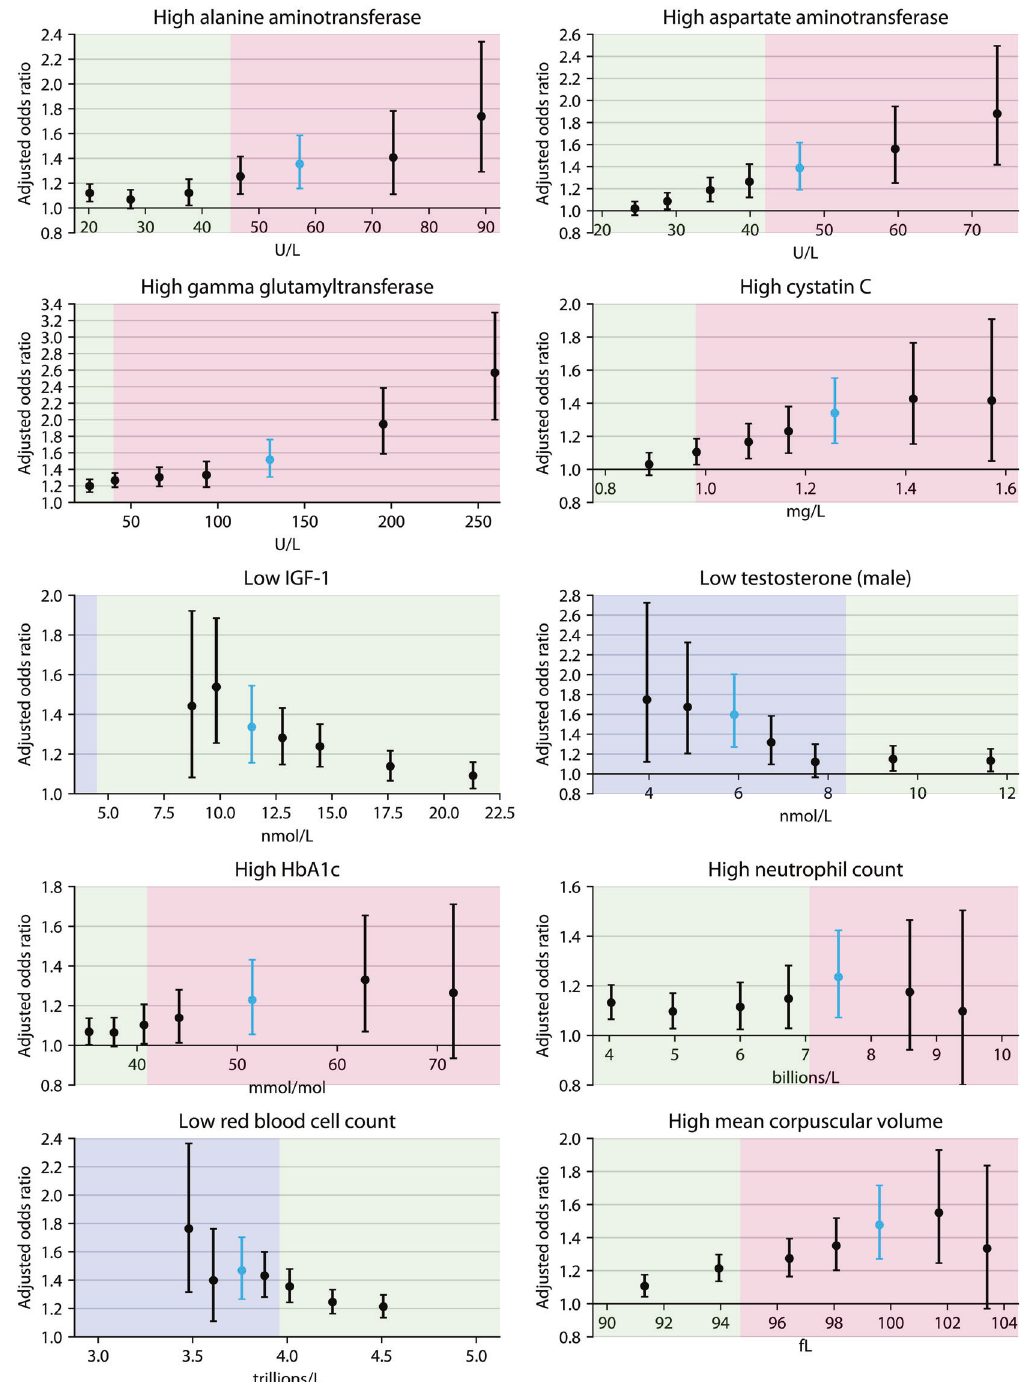
Fig. 3 Dependence of associations on the choice of percentile threshold. Adjusted odds ratios and 95% con fi dence intervals for 5-year MDD incidence at seven choices of the percentile threshold (top or bottom 0.5, 1, 2.5, 5, 10, 25, and 50%) for 10 of the 30 signi fi cant associations from the main analysis. (The remaining 20 are shown in Fig. S2.) The adjusted odds ratio at the original 2.5% threshold is highlighted in light blue. Green shading denotes reference ranges (see “ Methods “ ), with below-range values shaded blue and above-range values shaded bottom 99.5% (AOR = 1.88 [1.42, 2.50], FDR = 0.009%). Even for For most tests, adjusted odds ratios for MDD incidence were tests that did not follow this pattern, associations were relatively higher at more extreme thresholds (Fig. 3 and Fig. S2). For robust to the choice of threshold, including thresholds both inside instance, participants with above-median (top 50%) AST had a and outside the tests ’ reference ranges (with low IGF-1 being a similar incidence of MDD as those with below-median AST notable exception: very few individuals in the cohort met the (AOR = 1.02 [0.96, 1.08], FDR = 50%), but those with the highest Oxford criteria for being out of range). 0.5% of AST were at a substantially greater risk of MDD than the